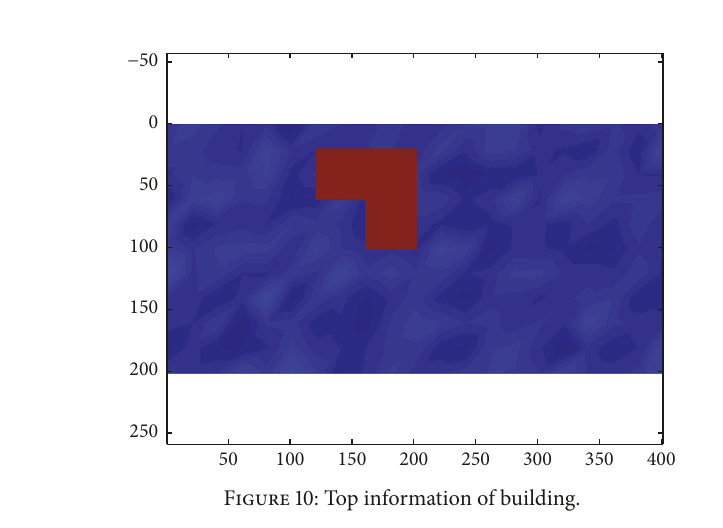
Figure 10: Top information of building.